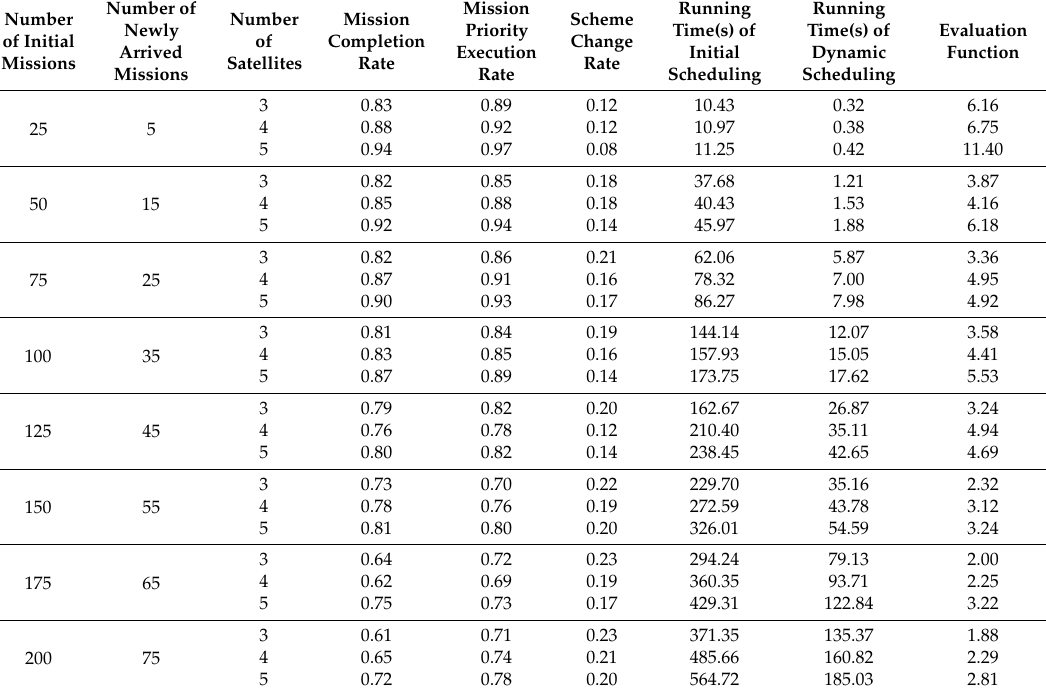
Table 13. Evaluation of scheduling results under different mission